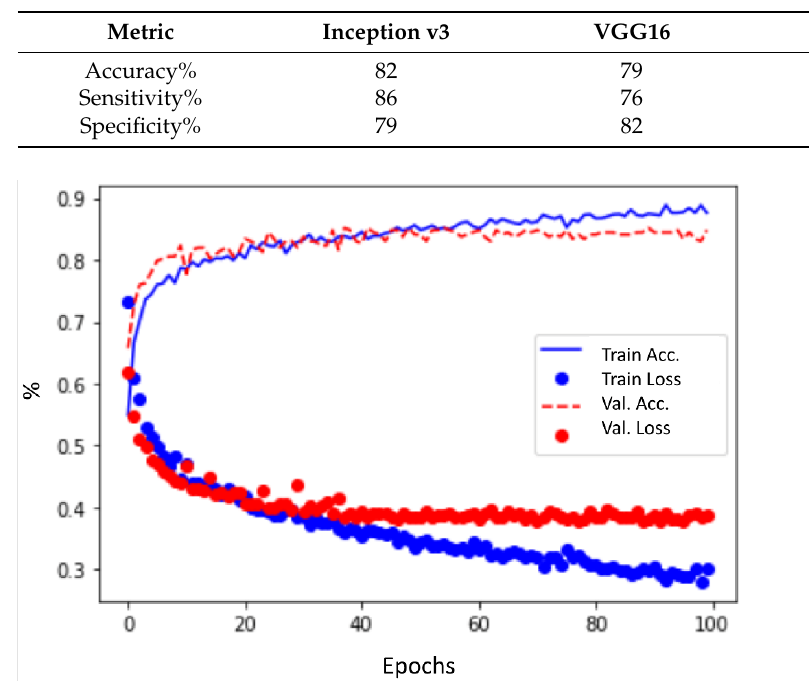
Figure 3. Graph depicting the learning curves and error rates of the Inception v3 model we used to classify the periapical areas. The graph shows the training accuracy (Train Acc.), the training loss (Train Loss), the validation accuracy (Val. Acc.) and the validation loss (Val. Loss) as a function of epochs. Training and validation loss decreased over time and stabilized at epoch 100. Training and validation accuracy on the other hand increased over time and stabilized at epoch 100. This indicated the convergence of the model after 100